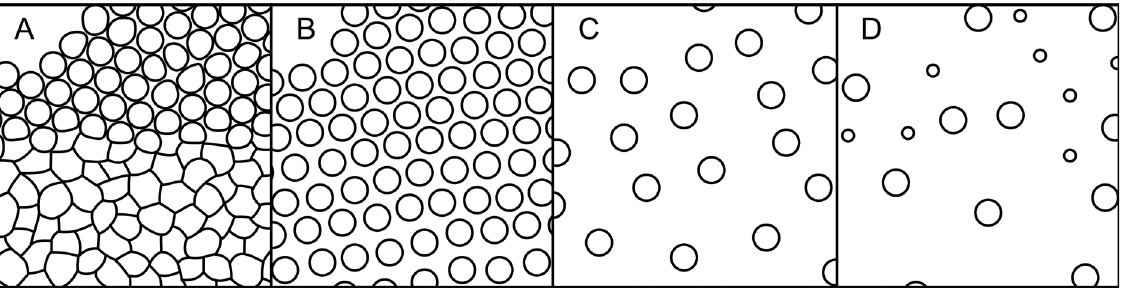
Fig. 1. Examples of punctation in Lasioglossum ( Dialictus ) Robertson, 1902. A . Crowded (IS = 0 PD) with few or no distinct interspaces in upper half to ruguloso-punctate in lower half. B . Dense (IS < 1 PD) but distinct. C . Moderately dense in upper half to moderately sparse in lower half (IS = 1–2 PD). D . Sparse (IS = 1–3 PD) and diversopunctate in upper